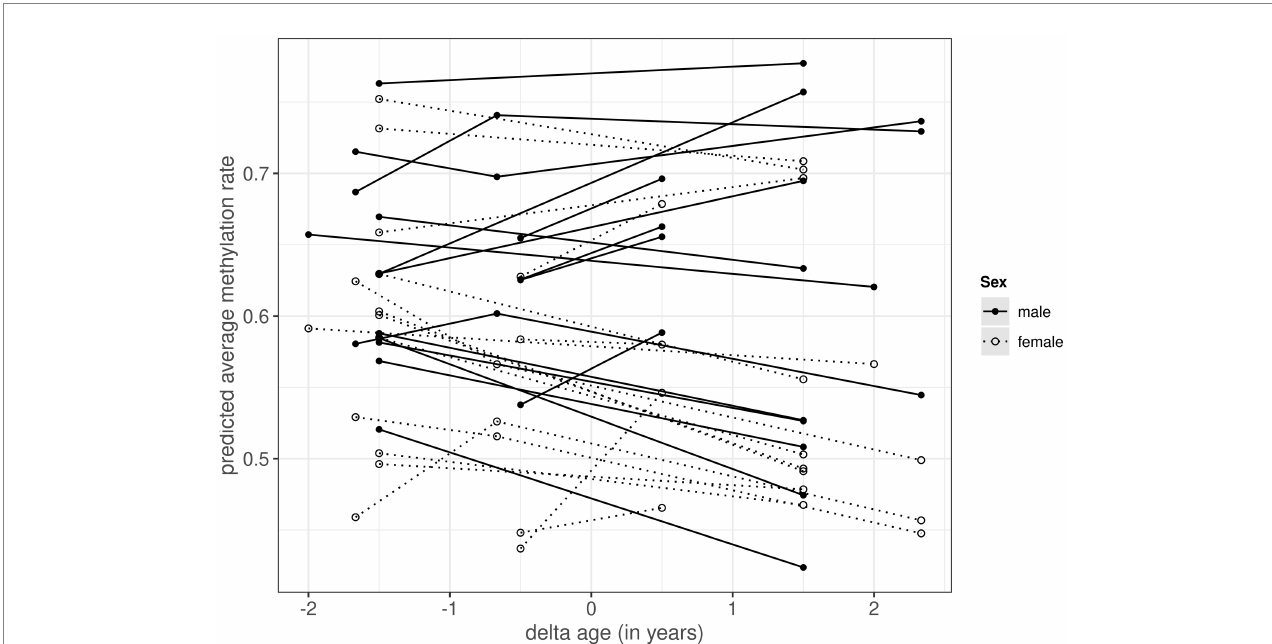
FIGURE 1 Within-individual changes in predicted average autosomal methylation rate for 17 male (black circles with solid lines) and 17 female (white circles with dotted lines) common terns sampled at 1, 3 and/or 4 year intervals. The x-axis, termed delta age, represents the within-individual difference in age (in years) in relation to the average age at sampling (at negative values the individual was younger than its average age at sampling, at positive values it was older). The predicted methylation rate on the y-axis is extracted from the model presented in Table 1, and based on 15,700 autosomal CpG